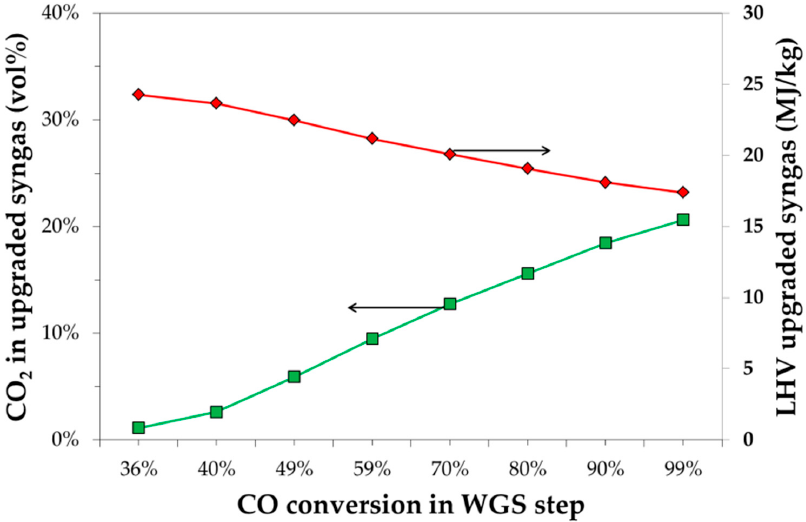
Figure 4. The effect of CO conversion in the WGS step on the CO 2 content (left axes) and low heat value (right axes) of the post-CCS, upgraded syngas.